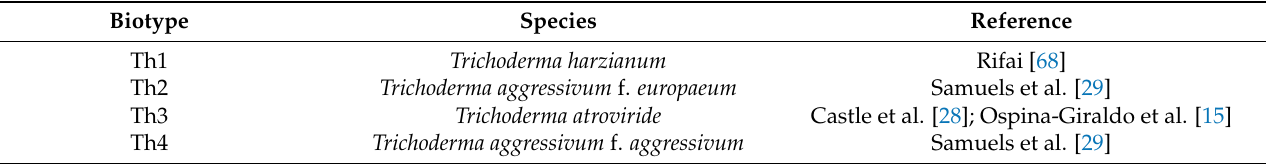
Table 2. Main Trichoderma harzianum green mold-associated biotypes found in Agaricus bisporus